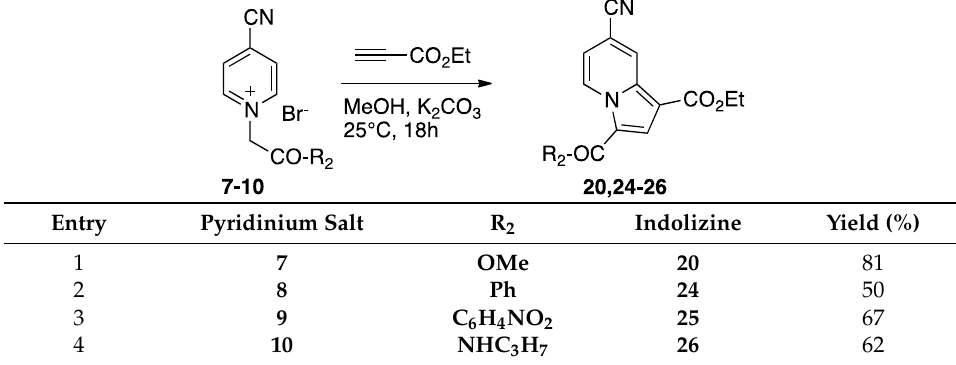
Table 5. Effect of the nature of R 2 group on the yield of 7-cyanoquinazolines.